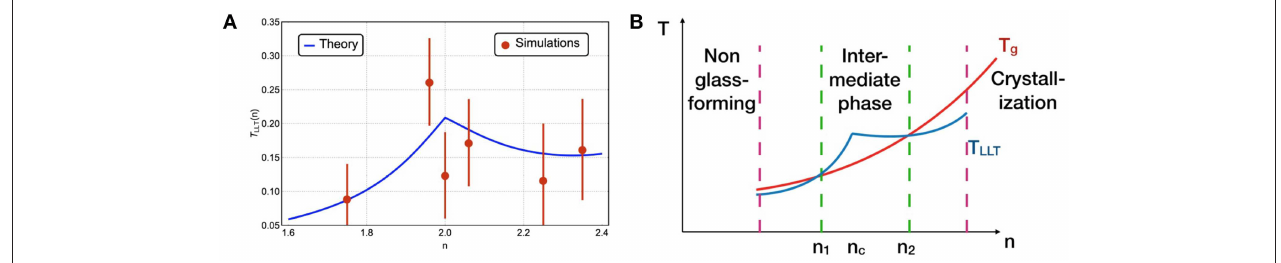
FIGURE 5 | (A) Liquid-liquid transition temperature vs. number of constraints, predicted by theory (blue line) and measured numerically for the network model for N = 256 (data points). Details of the theory and numerical extraction of T LLT are documented in Supplementary Note 6 . (B) Illustration of different dependence of T LLT and glass transition T g on the number of constraints n . When n is close to n c where T LLT becomes > T g , liquid is frozen in a homogeneous intermediate phase at T g